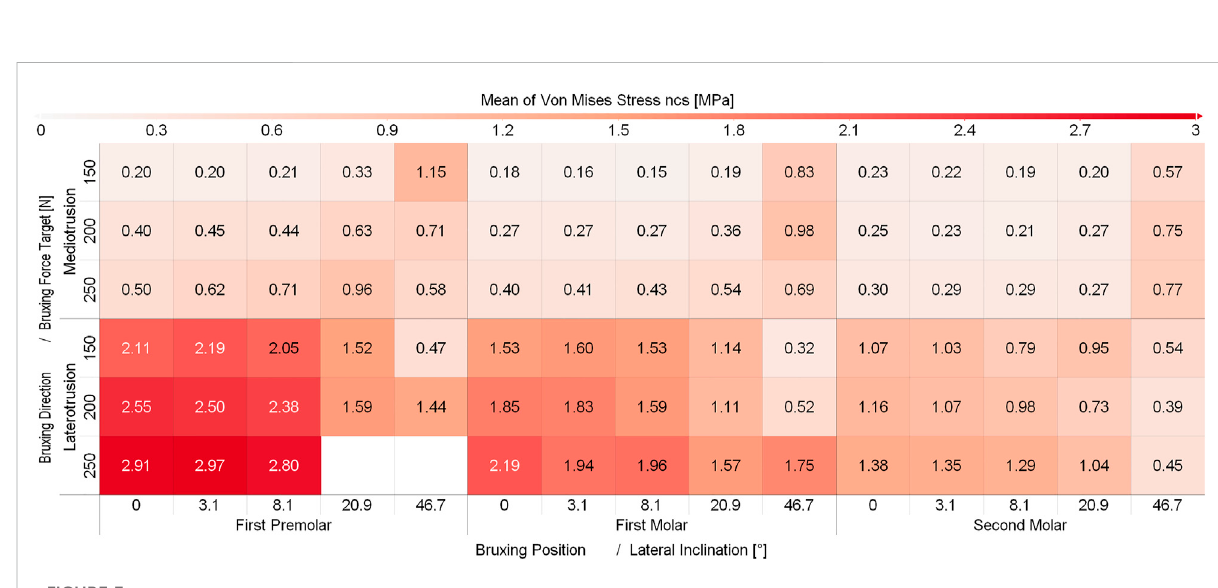
FIGURE 3 Mean von Mises Stress of the 200 highest loaded nodes on the non-contact side disc for different